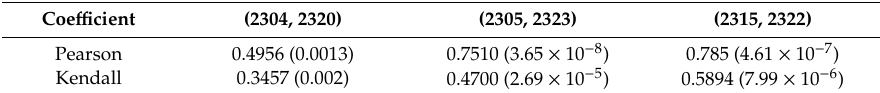
Table 3. Estimated Pearson and Kendall correlation coe ffi cients for the pairs of 7-day low-flow series: the values in parentheses are the corresponding p -values.